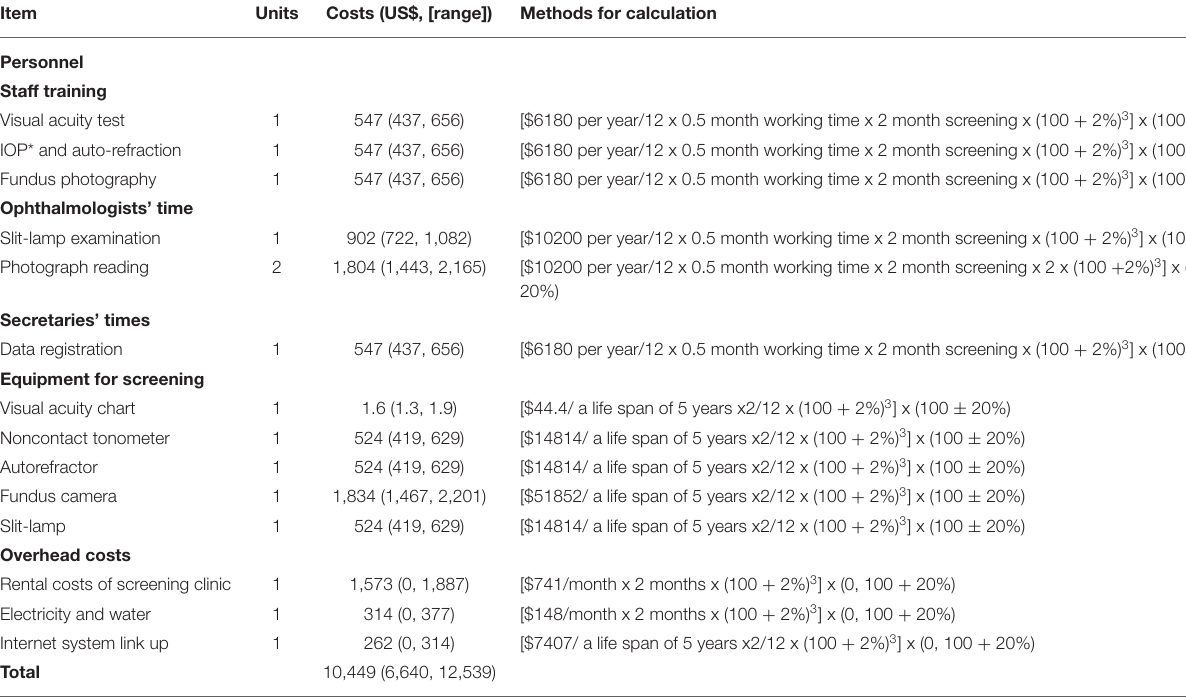
TABLE 4 | Costs for the